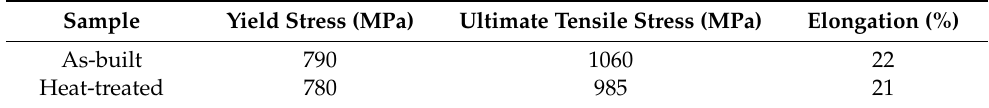
Table 7. Tensile properties of the as-built and heat-treated